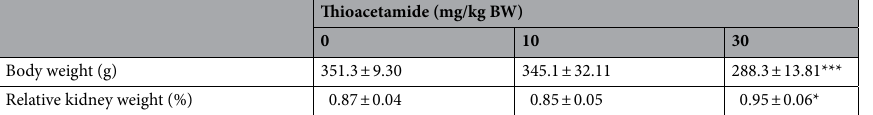
Table 1. Relative organ weight to body weight of rats exposed to TAA. Significant changes were indicated with * p < 0.05 and *** p < 0.001.